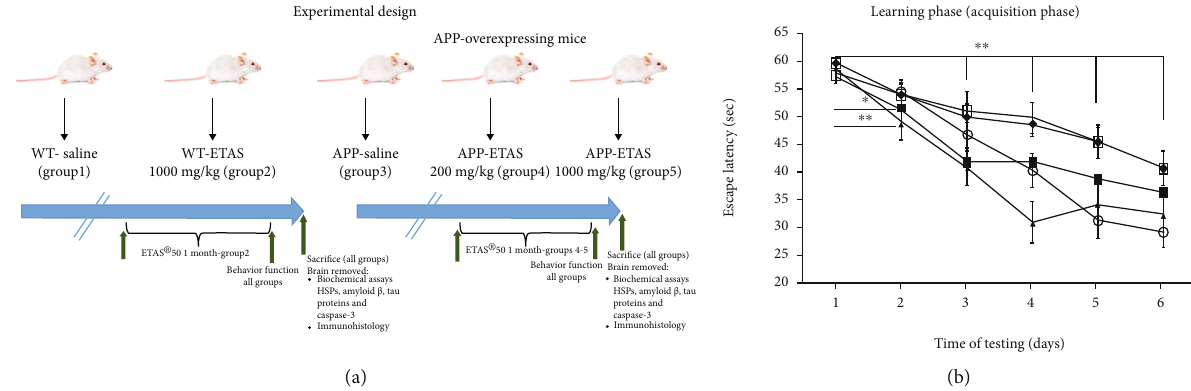
Figure 1: (a) Experimental design — scheme of animal groups ’ s description; (b) e ff ects of saline and/or ETAS (200mg/kg and 1000mg/kg) on APP-overexpressed mice and WT mice (1000mg/kg) on escape latency (acquisition phase) using the Morris Water Maze ( n = 10 mice in each group). ∗∗ p < 0 : 01 APP saline, APP-ETAS 200 and 1000 mg/kg; WT saline and WT-ETAS 1000 mg/kg at days 3 – 6 vs. day 1; ∗∗ p < 0 : 01 APP- ETAS 1000mg/kg at day 2 vs. day 1; ∗ p < 0 : 05 APP-ETAS 200 mg/kg day 2 vs. day 1. ♦ APP saline; ■ APP-ETAS 200 mg/kg; ▲